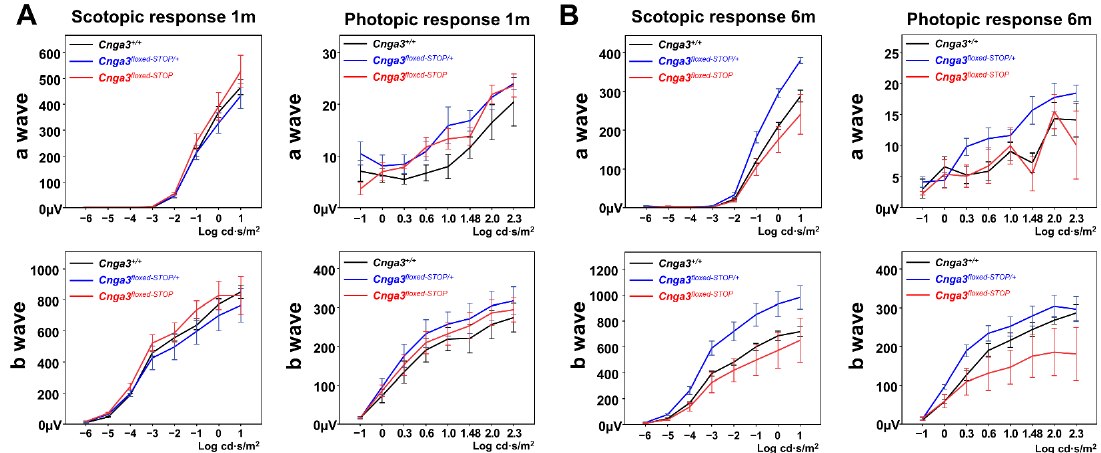
Figure 5. Electroretinography (ERG) of Cnga3 floxed-STOP mice. ( A ) Scotopic and photopic serial intensity ERG tracings of Cnga3 floxed-STOP mice showed no decrease in b -wave amplitudes compared to the Cnga3 +/+ and Cnga3 floxed-STOP/+ mice from the same litter at 1-month old. (n Cnga3+/+ = 5, n Cnga3floxed-STOP/+ = 4, n Cnga3floxed-STOP = 6) ( B ) Although the photopic b-wave amplitudes are smaller in Cnga3 floxed-STOP mice at 6 months old, the difference is not statistically significant. (n Cnga3+/+ = 3, n Cnga3floxed-STOP/+ = 3, n Cnga3floxed-STOP = 5). Int. J. Mol. Sci. 2021 , 22 , x FOR PEER REVIEW